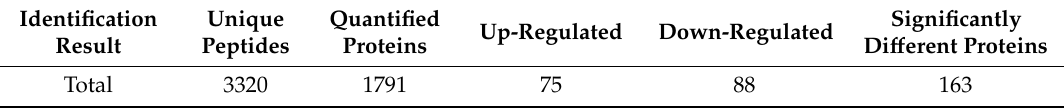
Table 1. Statistics on the protein identification results.